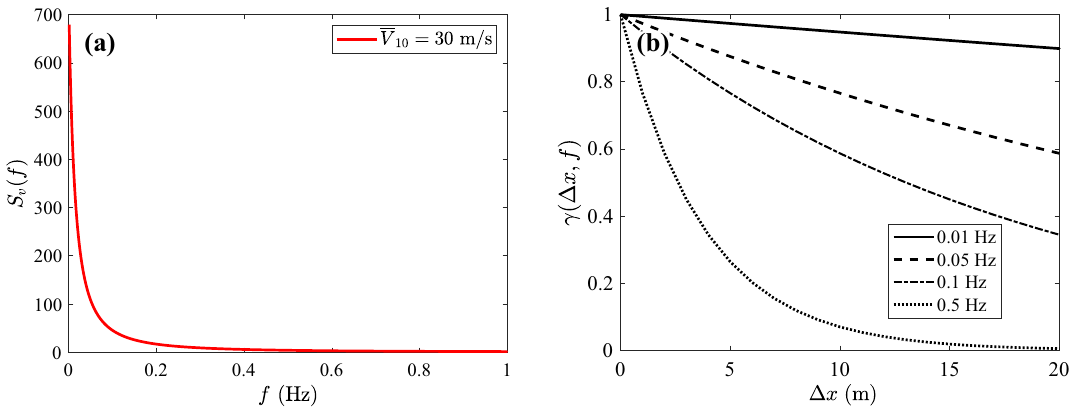
Figure 13. Characterization of turbulent wind with V 10 = 30 m/s: ( a ) PSD from Eq. (2); ( b ) coherence from Eq.